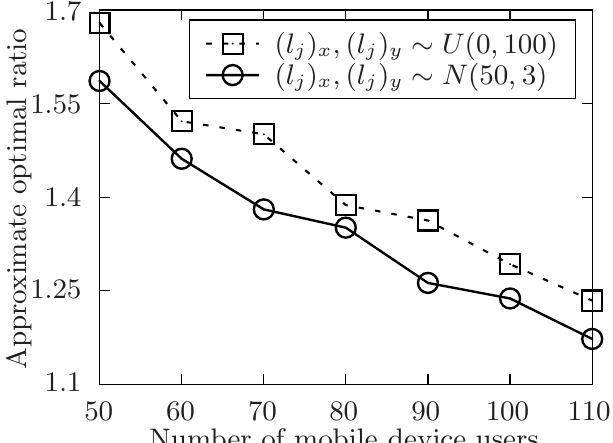
Figure 7. The approximate optimal ratio of the proposed algorithm vs. different l when | T i | ∼ U ( 4,10 ) or U ( 8,14 ) .